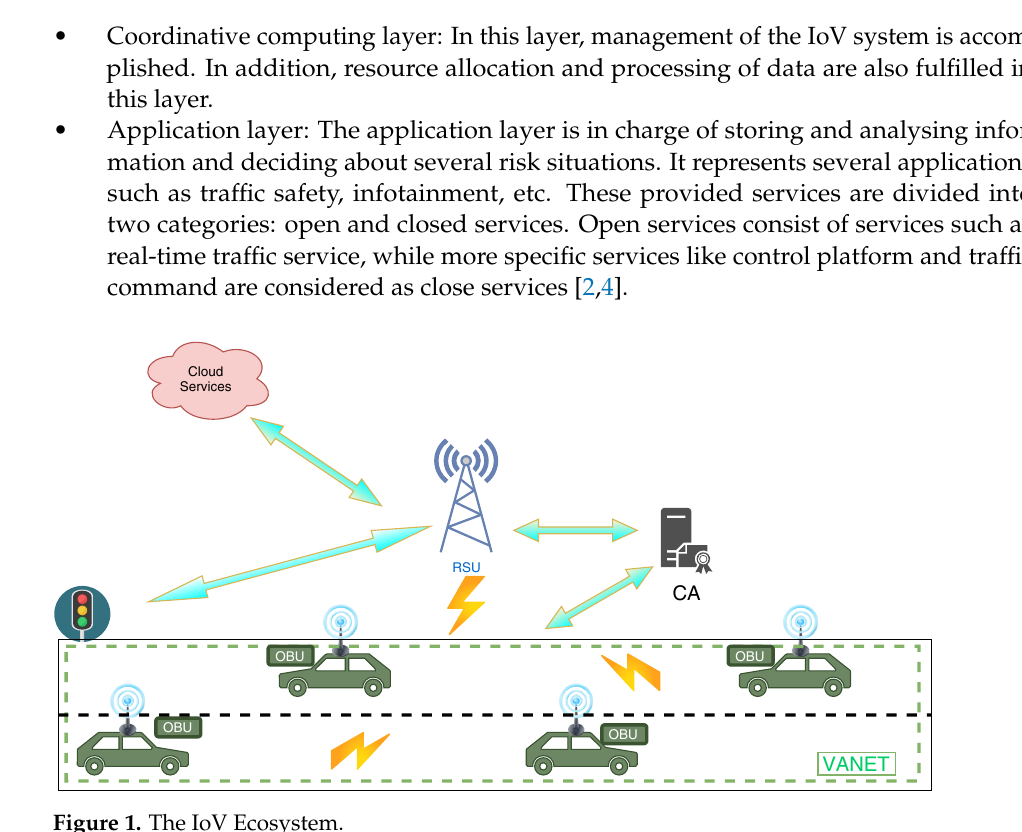
Figure 1. The IoV